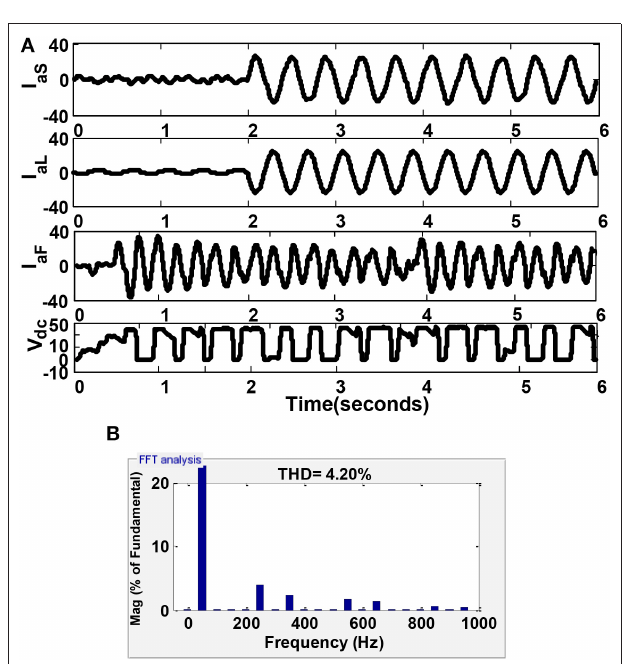
FIGURE 8 | Power quality analysis in three phase system using the RLS algorithm under unbalanced load conditions: (A) simulation results showing supply current, load current, filter voltage, and DC-bus voltage; and (B) THD value of 4.26%.